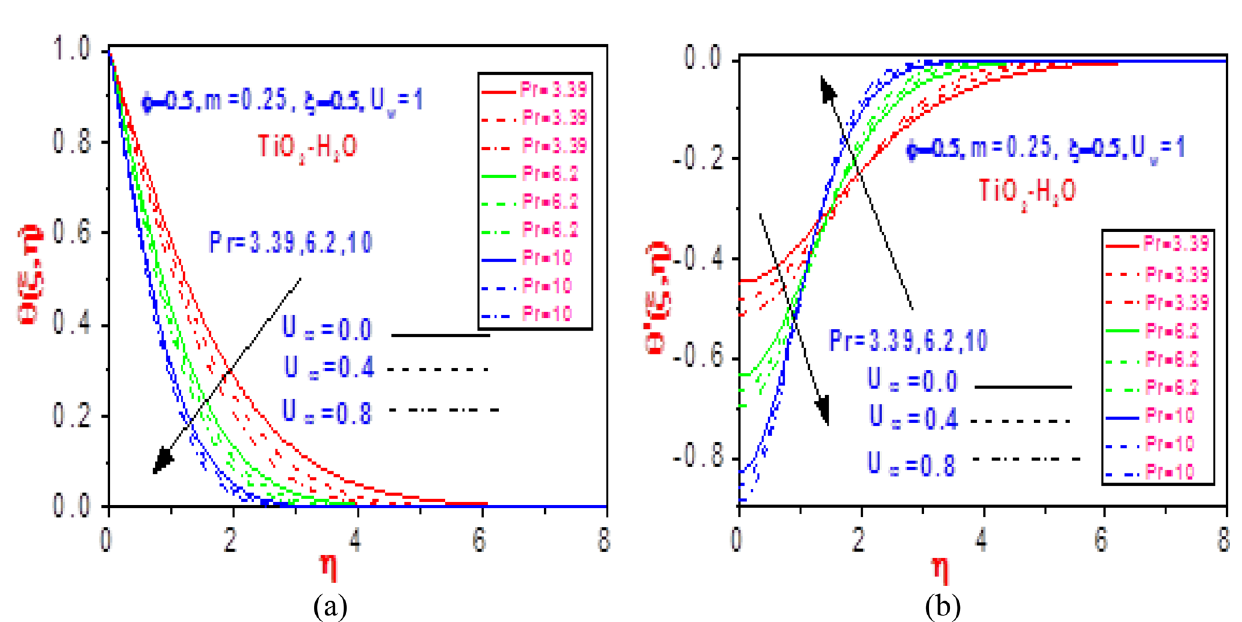
Figure 12. Profiles of ( a ) temperature θ(ξ , η) and ( b ) missing temperature slope θ ′ (ξ , η) with different values of U ∞ and Pr for TiO 2 -H 2